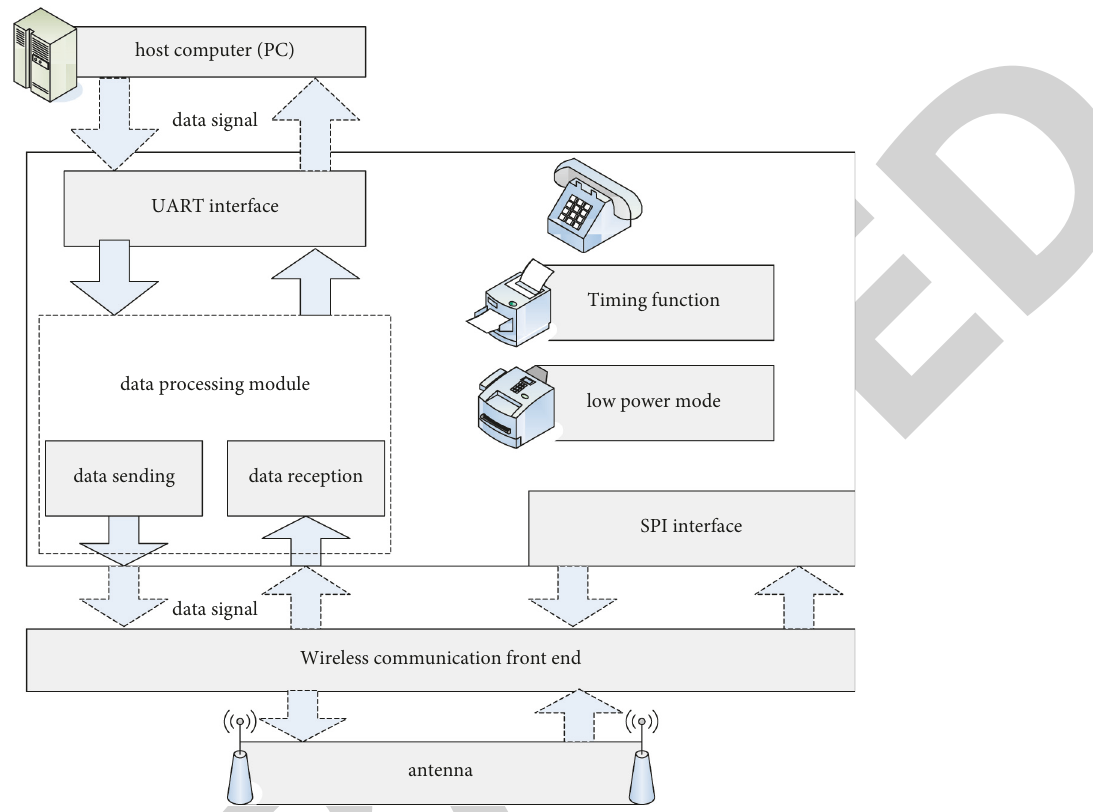
Figure 2: Embedded wireless communication system architecture.